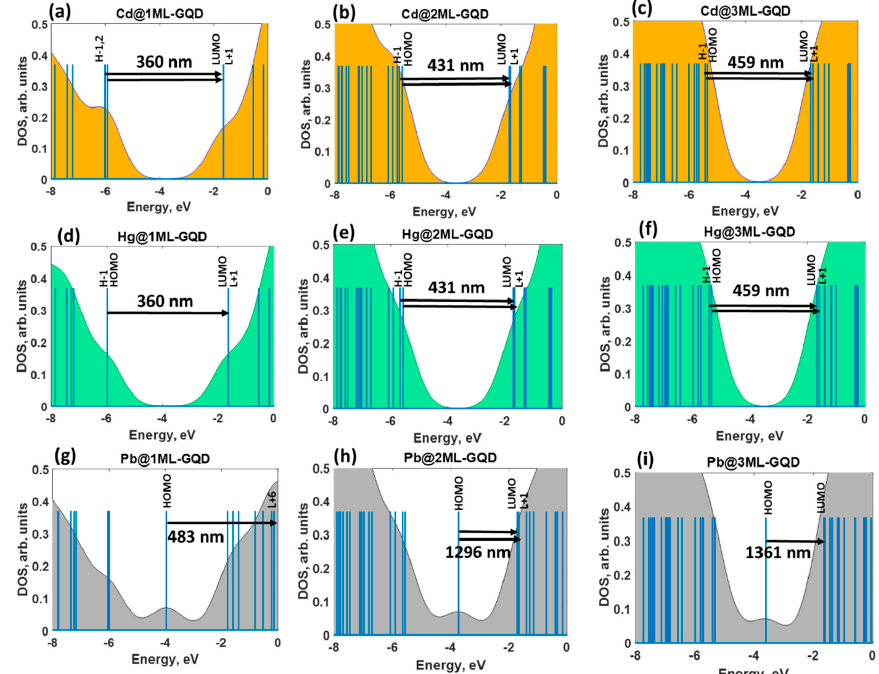
Figure 4. Calculated density of the states (shaded area) of the thickness-varying GQDs interacting with elemental heavy metals: ( a – c ) Cd, ( d – f ) Hg, and Pb ( g – i ), respectively. Blue vertical lines correspond to the molecular orbitals. Horizontal black arrowed lines show the excited transitions between the available occupied and unoccupied electronic levels.